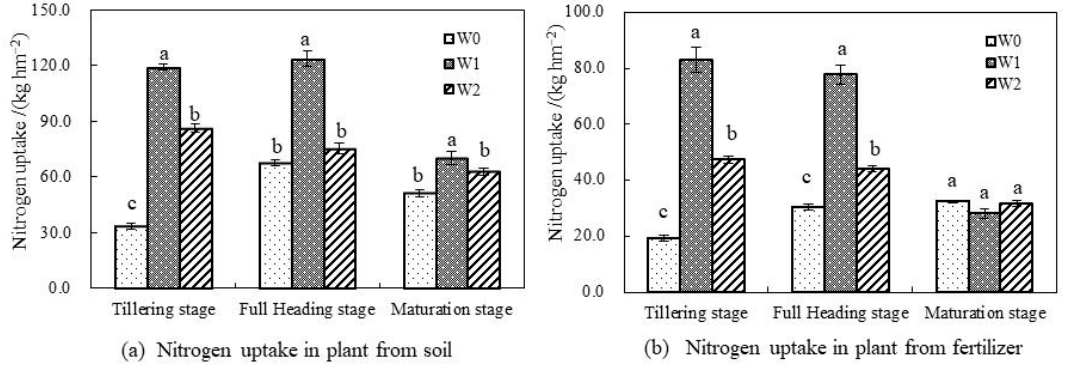
Figure 4. Nitrogen uptake by rice plant under different irrigation modes, Figure a described nitrogen uptake loss from soil, and Figure b described nitrogen uptake loss from fertilizer (a, b and c in the figure represented differences between groups for significance analysis). Table 2. Nitrogen uptake by rice grain and plant under at maturation stage kg/hm 2 ( a , b and c in the figure represented differences between groups for significance analysis).